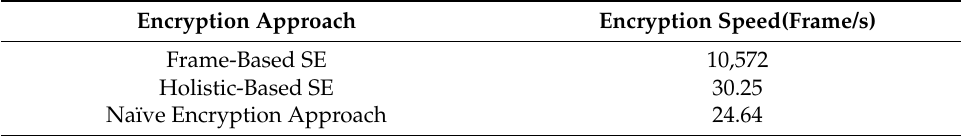
Table 6. Encryption speed of the multi-frame encryption approach.